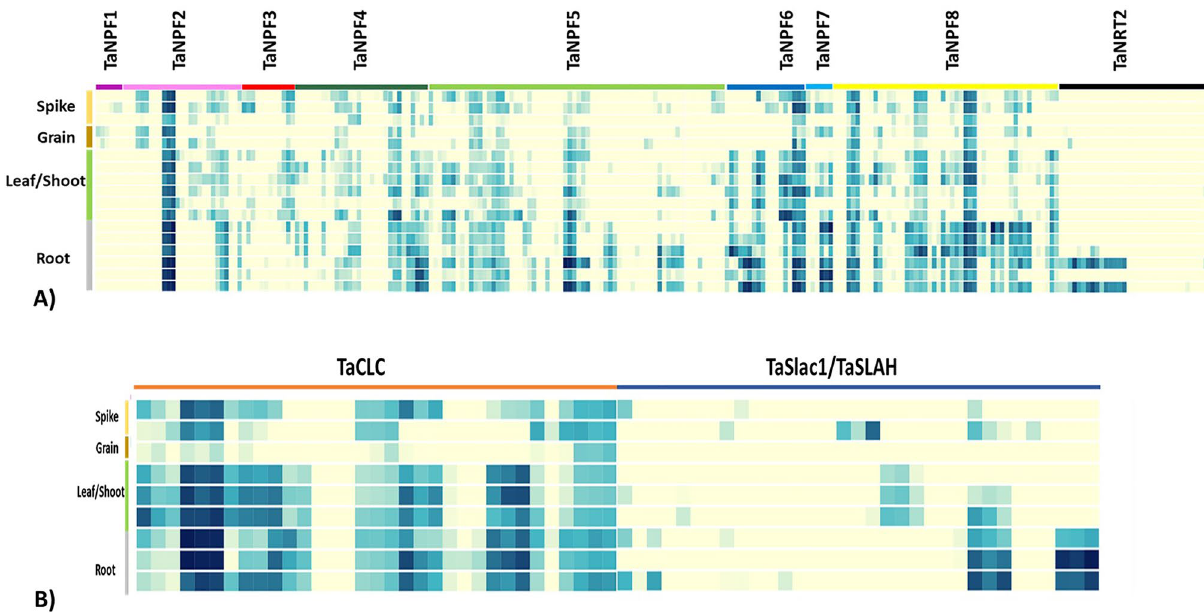
Figure 5. Expression patterns of nitrate transporter gene triads in wheat ( a ) Tissue and development stage specific expression profiles of TaNPF and TaNRT2 genes ( b ) Tissue and development stage specific expression profiles of TaCLC and TaSLAC1/SLAH genes. The heat maps were generated by heatmap tool from wheat expression database 42 (http:// wheat- expre ssion. com/).